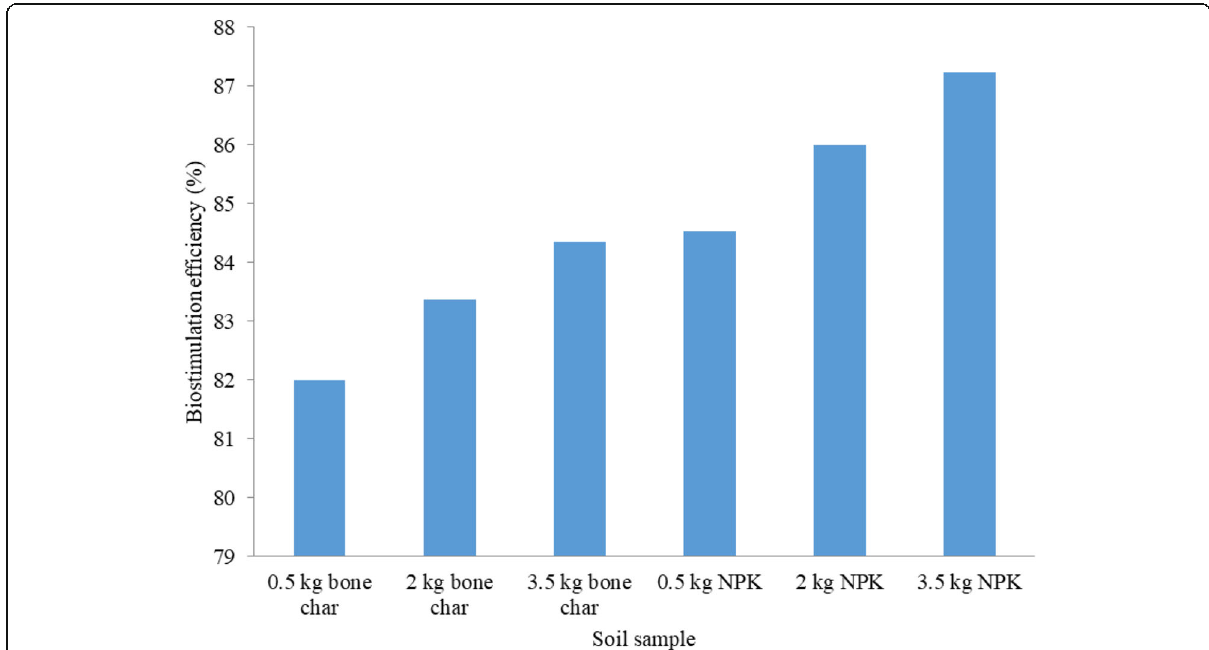
Fig. 5 Biostimulation efficiency